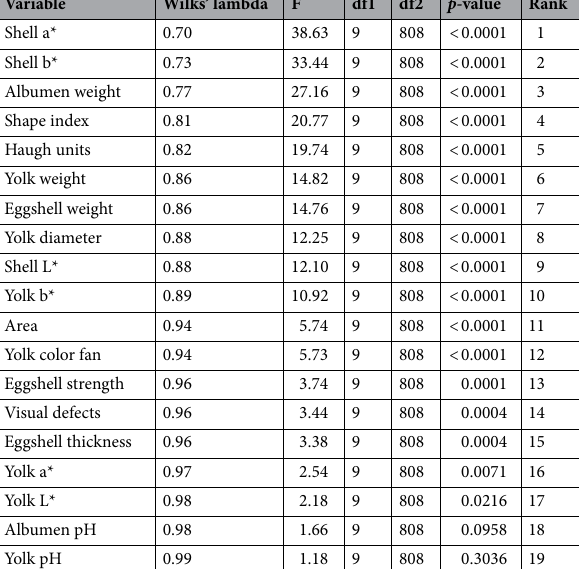
Table 3. Results for the tests of equality of group means to test for difference in the means across egg groups once redundant variables have been removed.